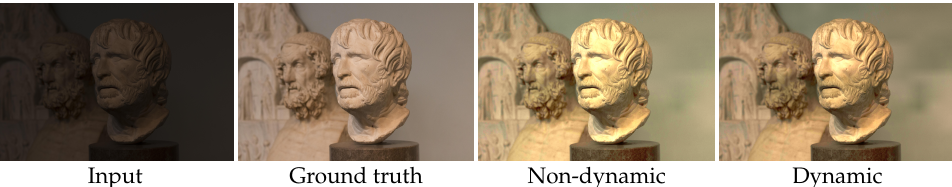
Figure 3. Comparison of subjective results with different fusion strategies, with non-dynamic and dynamic results respectively corresponding to Equations (12) and